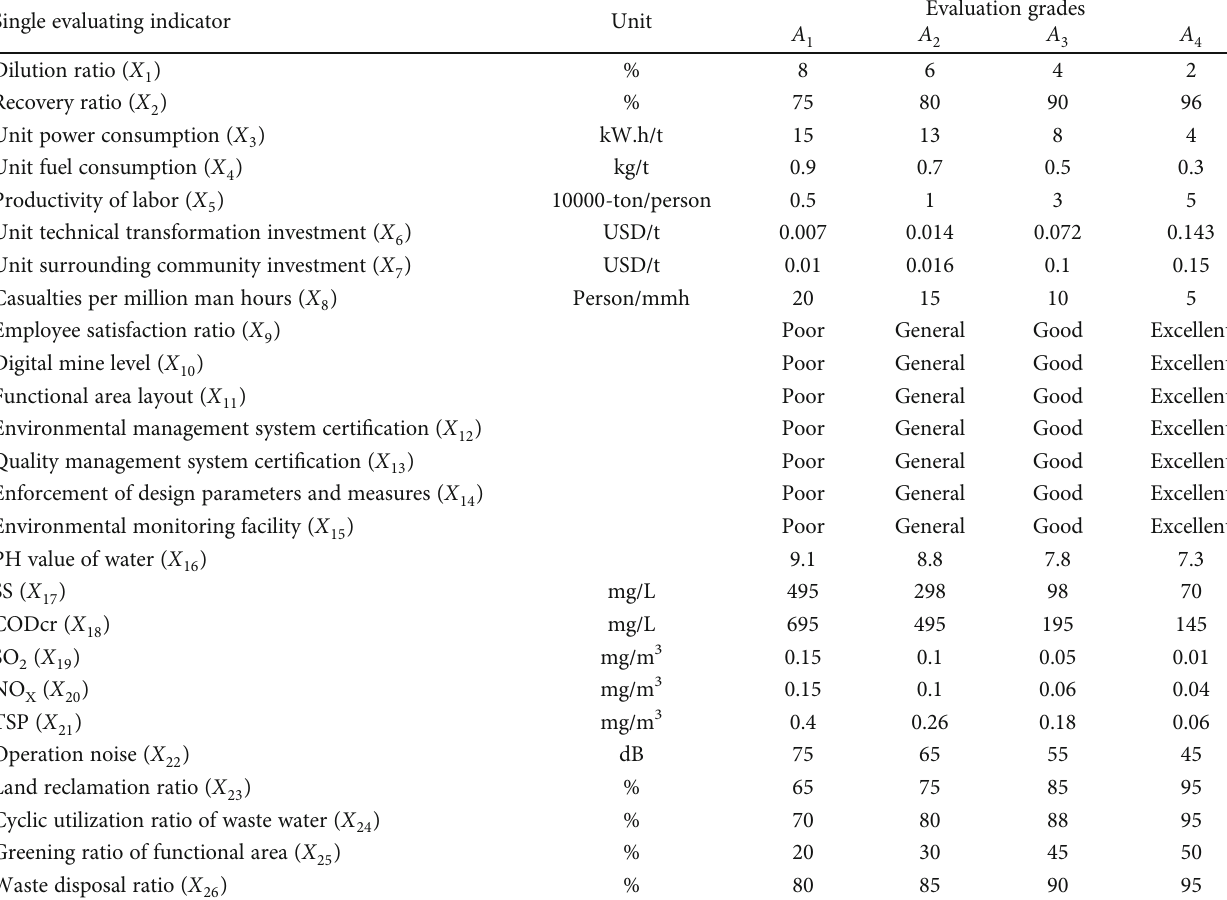
Table 1: Evaluation grades of the qualitative indicators and quantitative